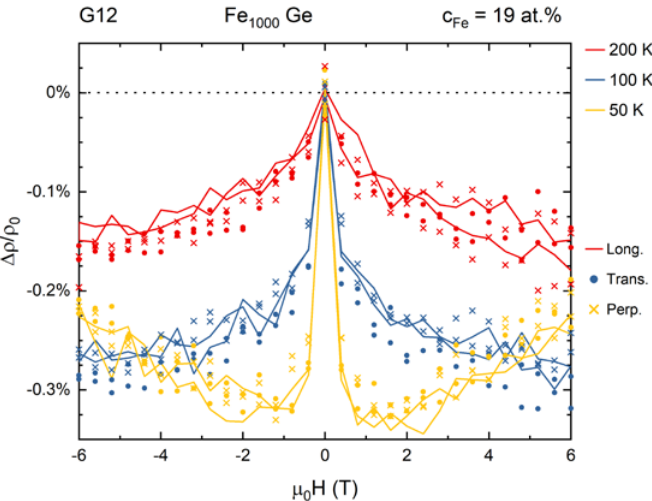
Figure A1. Magnetoresistance curves of sample G12 at three different temperatures in longitudinal (lines), transverse (circles) and perpendicular orientation (crosses). Evidently, the underlying magnetoresistance effects are isotropic.